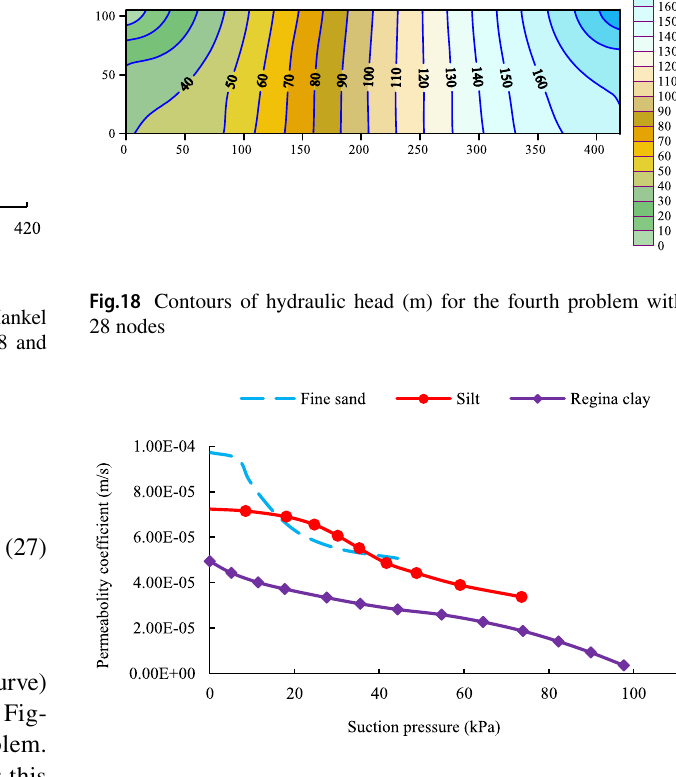
Fig. 19 Unsaturated permeability function for different soils (Lam et al,